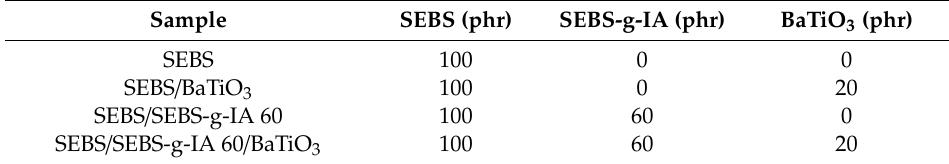
Table 1. Composition of poly(styrene- b -ethylene-butylene- b -styrene) (SEBS) / BaTiO 3